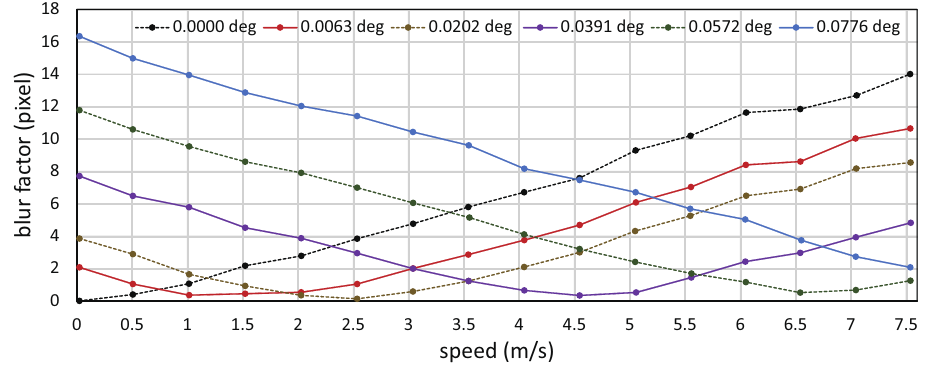
Figure 15. Blur indexes λ dot when video shooting without actuator